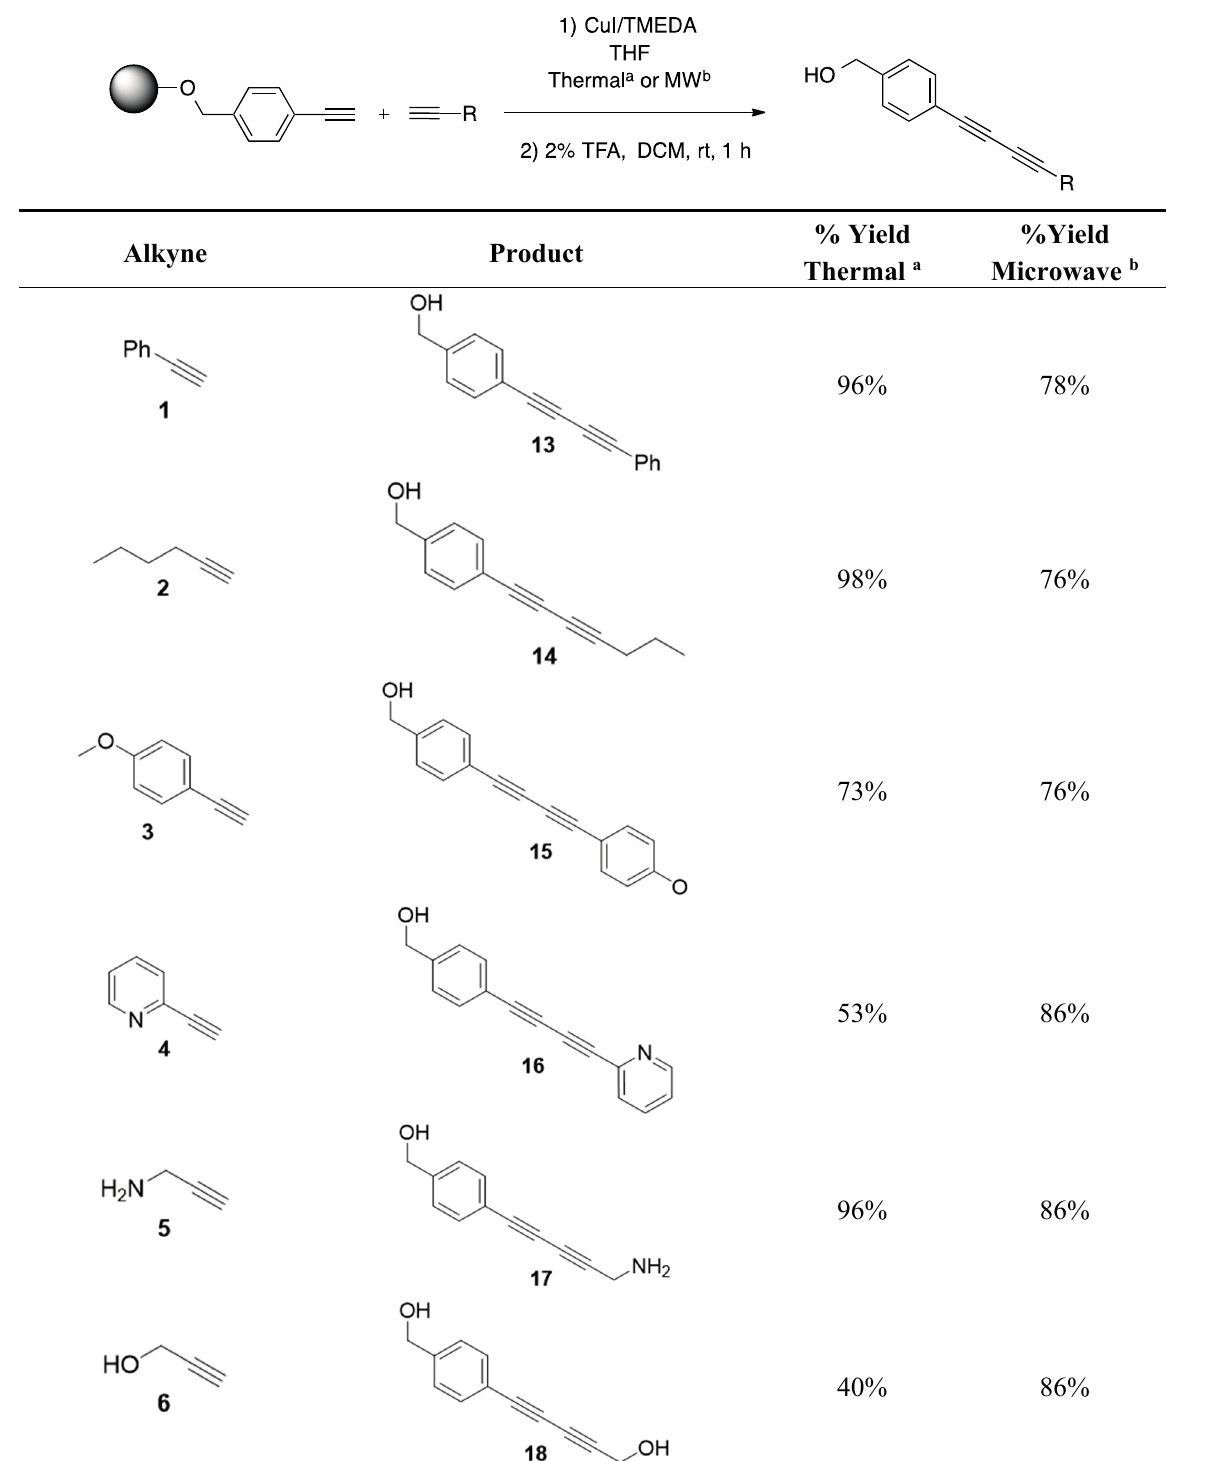
Table 3. Ethynyl Benzyl Alcohol Derivatized Resin Glaser-Hay